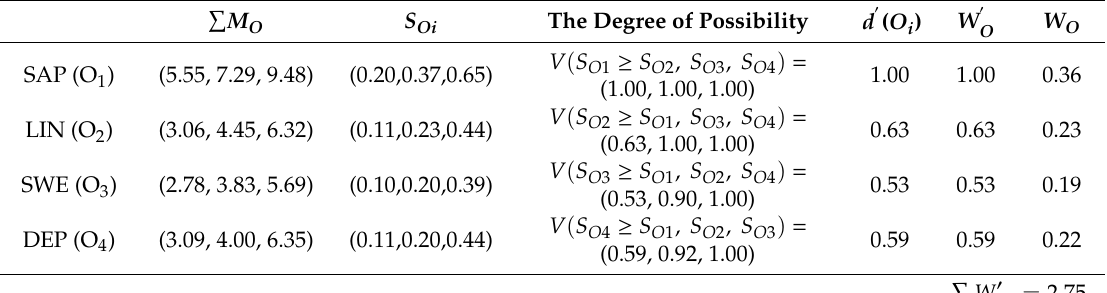
Table 6. The weight vector of O 1 –O 4 with respect to the goal.